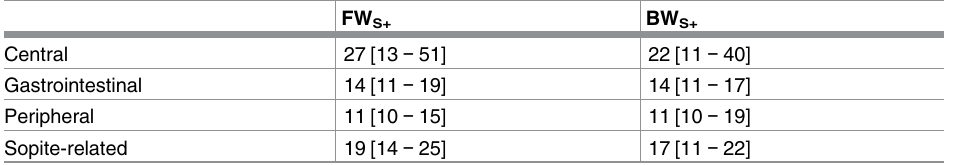
Table 3. Median scores (in %) and interquartile range (IQR) results of the MSAQ. The first (Q1) and third quartiles(Q3) are shown betweensquare brackets. FW S+ BW S+ Central 27 [13 − 51] 22 [11 − 40] Gastrointestinal 14 [11 − 19] 14 [11 − 17] Peripheral 11 [10 − 15] 11 [10 − 19] Sopite-related 19 [14 −